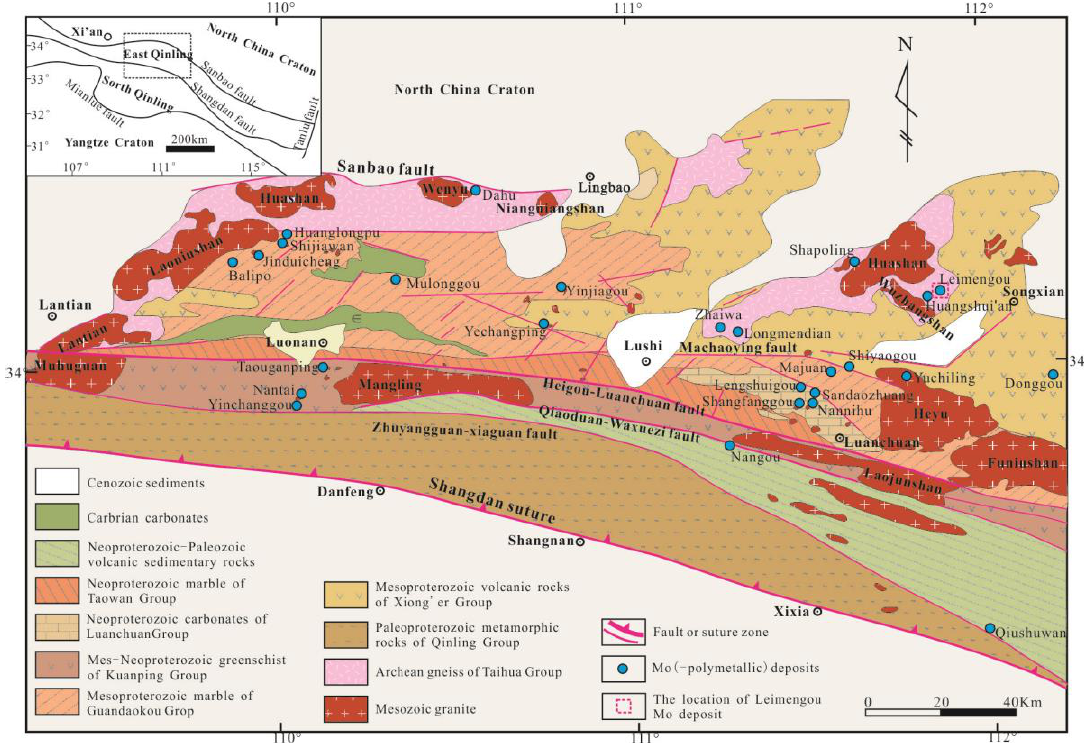
Figure 1. Distribution pattern of the late Mesozoic intrusions in the East Qinling orogenic belt (modified after Mao et al., 2010 [7]).